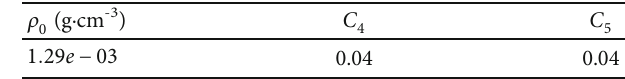
Table 3: Parameters for